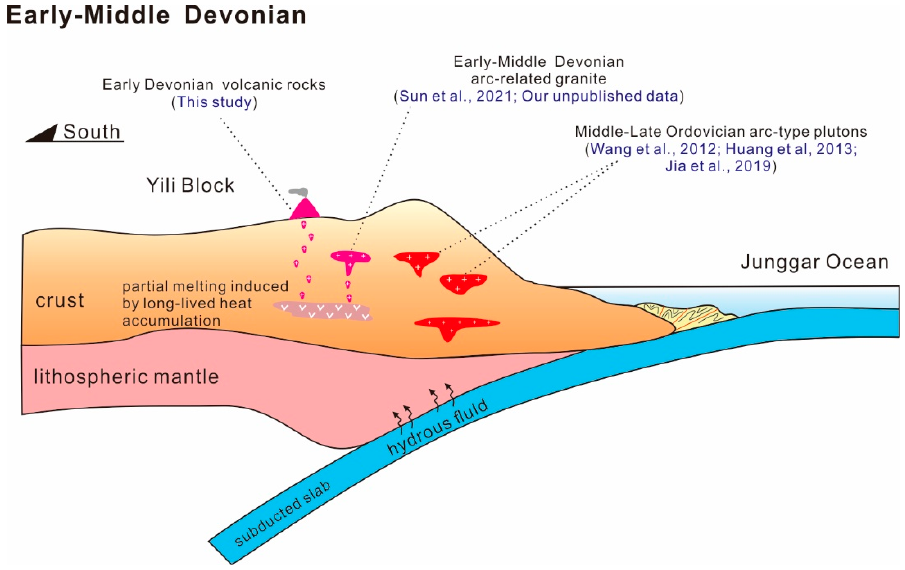
Figure 11. Tectonic model of the north margin of Yili Block during the Early-Middle Devonian.